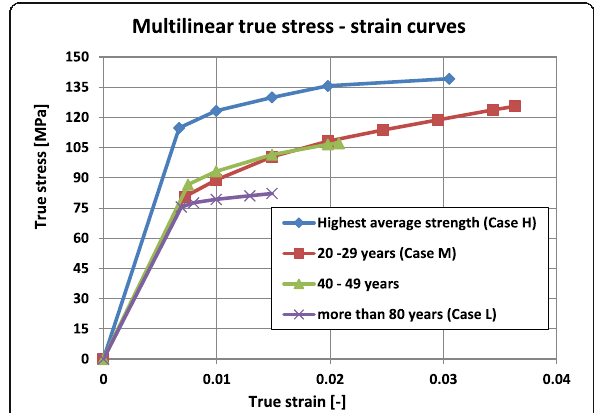
Fig. 8 Multilinear true stress – strain curves used to evaluate the total strain: The age-related curves were based on the stress – strain curves from (Ott 2007; Ott et al. 2010). The highest average strength curve was chosen using the mean tensile strength values from (Reilly and Burstein